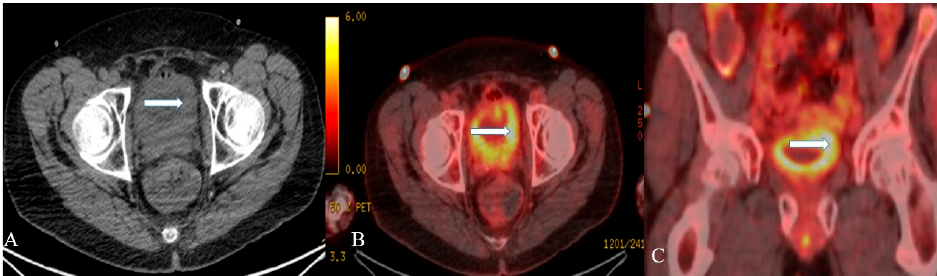
Figure 10. A 48-year-old female with urinary bladder NEN. Axial CT without contrast ( A ), axial ( B ), and coronal ( C ) reconstruction fused PET/CT images show thickened urinary bladder wall (arrows), which is most evident on the left side. The maximum thickness measures 2.4 cm and has an SUV of 8.2. Pathology revealed small-cell neuroendocrine carcinoma of the urinary bladder.